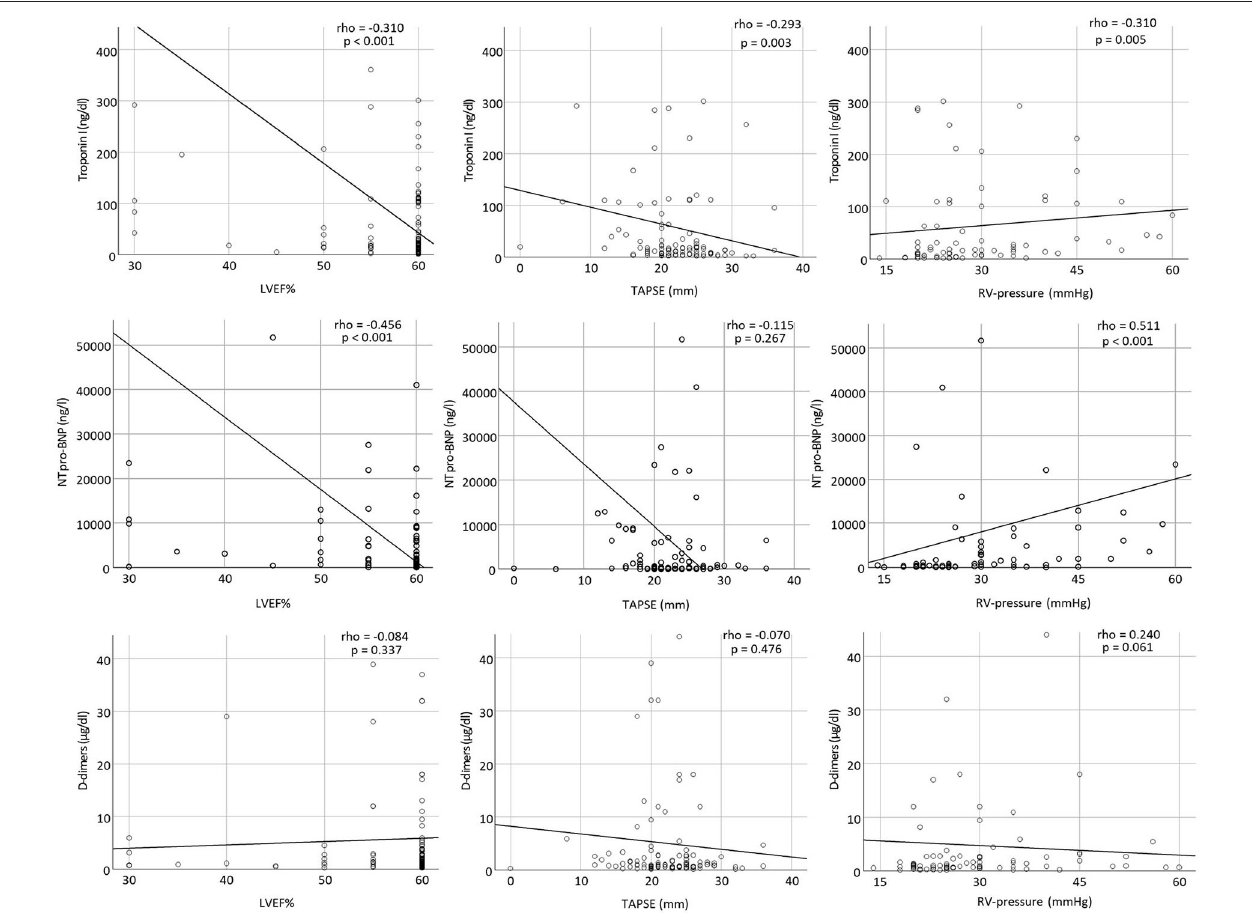
Frontiers in Cardiovascular Medicine |